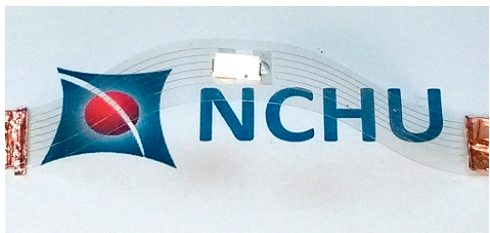
Figure 8. Demonstration of conductive silver line fabricated by LDSP on the transparent PET substrate.